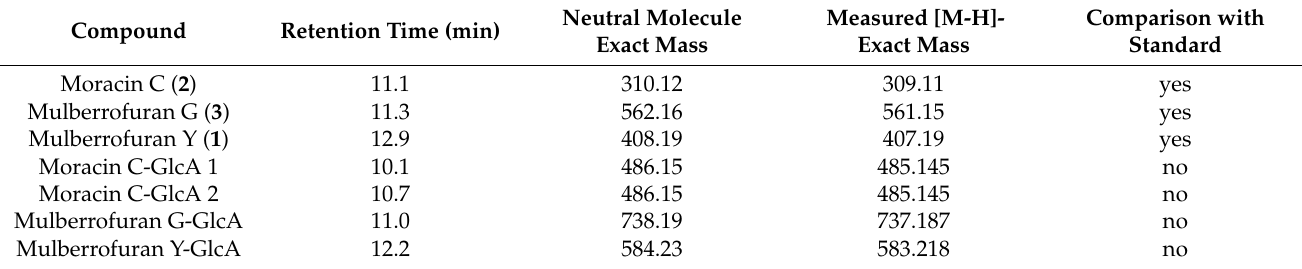
Table A2. List of the compounds monitored and detected in the samples by the LC/MS system.